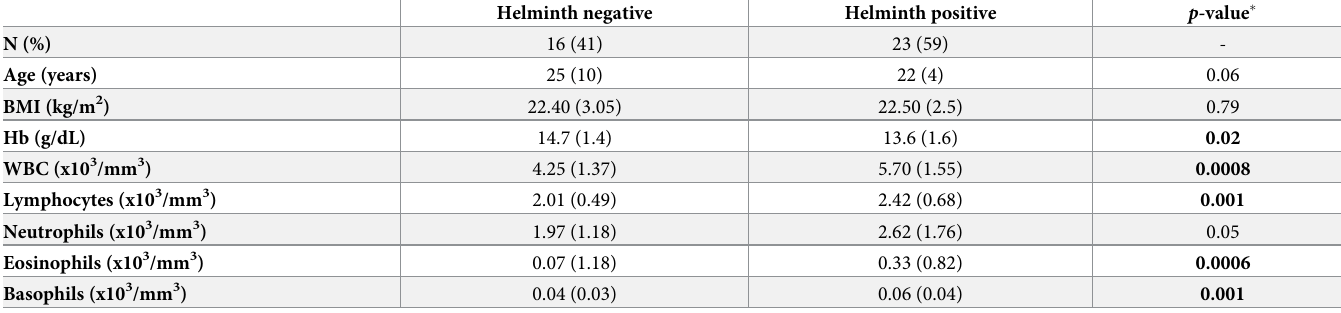
Considering the sub-study groups, we found a relationship between S . haematobium status ( p-value = 0.01), S . stercoralis ( p-value = 0.03) status and vaccine-specific IgG concentration on D84. Compared to anti-GMZ2 IgG concentration on D84 in those uninfected (mean log concentration ± SD: 3.49 ± 0.14), participants infected with S . haematobium alone presented a higher level of anti-GMZ2 IgG (3.69 ± 0.10), while those infected with S . stercoralis alone had lower anti-GMZ2 IgG levels (3.32 ± 0.19) (Fig 3A). Additionally, a significantly lower level of anti-GMZ2 IgG was observed in Str+ individuals compared with the Sh+ individuals ( p-value = 0.0008), Tt+/Hw+ individuals (3.62 ± 0.16, p-value = 0.003) and CoInf+ individuals (3.49 ± 0.17, p-value = 0.03) (Fig 3A). No significant differences between the groups were observed when applying a correction for multiple comparison. In addition, no relationships were observed for either anti-MSP3 or anti-GLURP IgG levels and helminth status (Fig 3B and 3C).